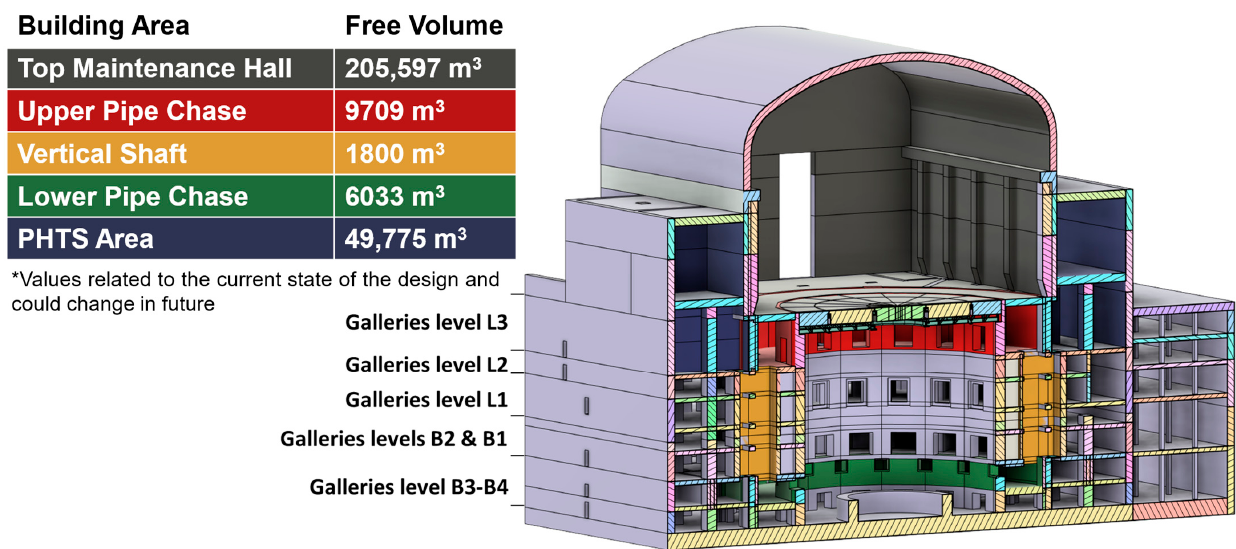
Figure 2. EU DEMO Tokamak Building cross section highlighting free volumes available for steam expansion and building galleries levels.